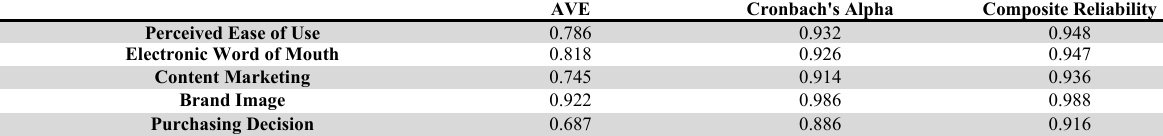
AVE, Cronbach’s Alpha, Composite Reliability